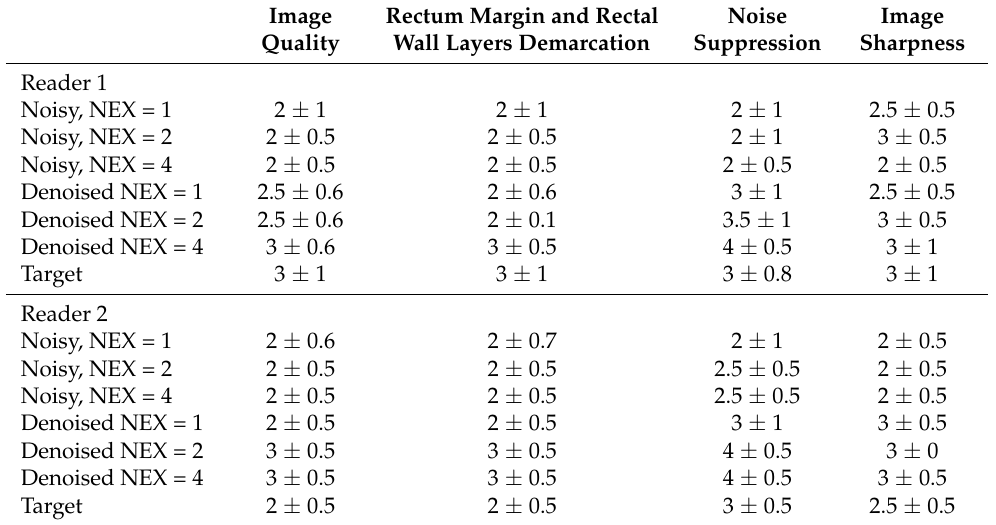
Table 3. Qualitative image qualitative evaluation was performed by two expert radiologists. Median ± IQR scores are shown for each reader and image quality category.